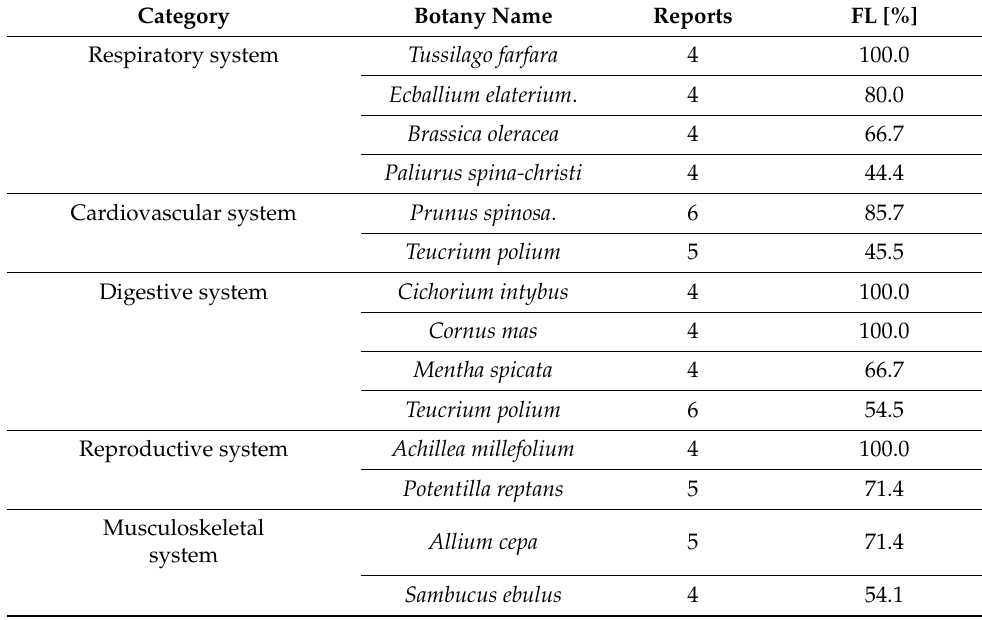
Table 5. FL by diseases categories for East Rhodopes (number of reports > 3).